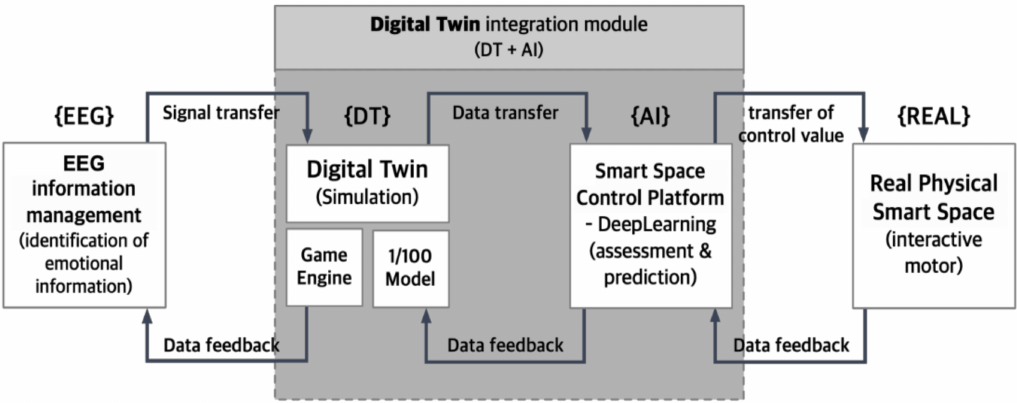
Figure 5. Schematic of feedback loop formed by EEG information management and smart space control